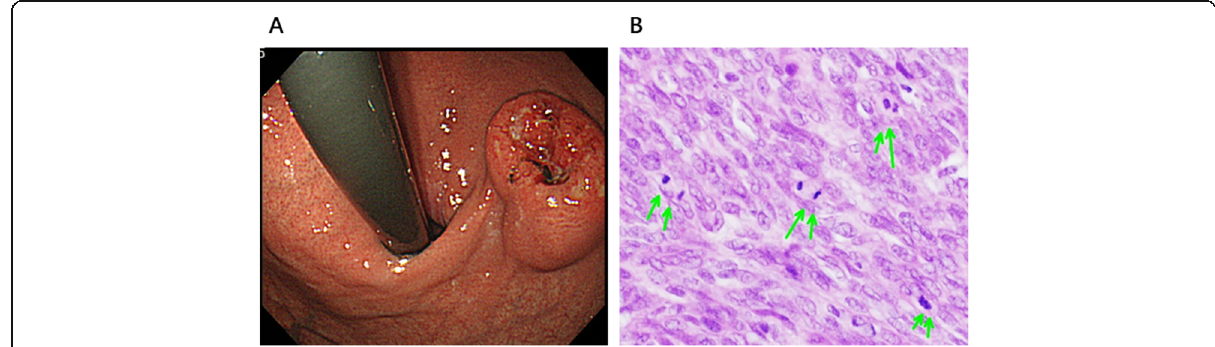
Fig. 1 a Gastrointestinal endoscopic examination showed a submucosal tumor 35 mm in diameter at the anterior wall of the gastric cardia. b Histological examination of the resected specimens showed a nuclear fission image with 50 high-power